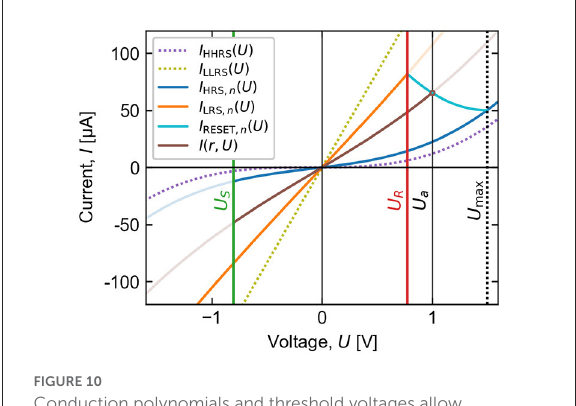
FIGURE10 Conduction polynomials and threshold voltages allow reconstruction of ( I , U ) cycles from generated feature vectors. Simulated resistance switching is such that the conduction state I ( r , U ) induced by an applied voltage U a intersects the U a . For visual simplicity, the cycle reconstructed cycle at U = R H , n shown begins and ends in the same HRS ( R H , n ). = + 1